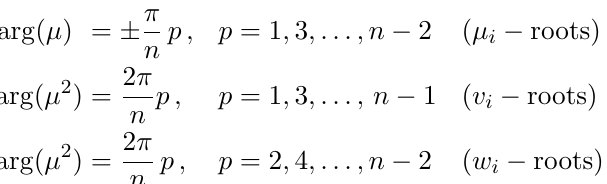
along the rays given by (see (cid:12)gure